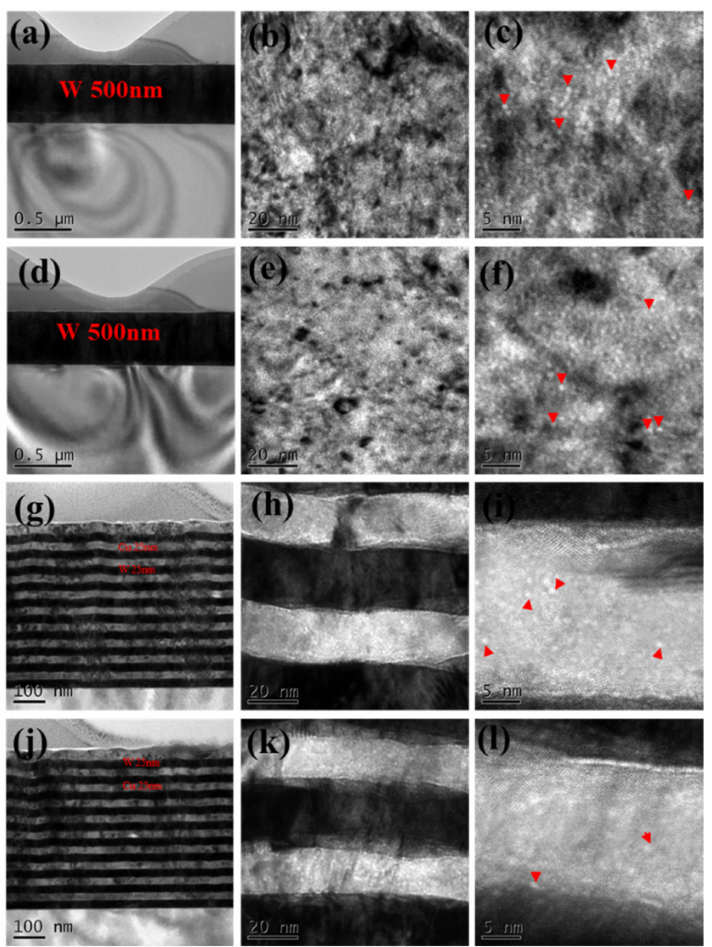
Figure 3. The microstructure of the W monolayer and the W/Cu-25 nanocomposite after He + irradiation: ( a ) The cross–sectional TEM–bright field (TEM–BF) image, ( b , c ) the helium bubbles, under focus ~300 nm, of He + irradiated W monolayer at RT; ( d ) the cross–sectional TEM–bright field (TEM–BF) image, ( e , f ) the helium bubbles, under focus ~300 nm, of He + irradiated W monolayer at 400 ◦ C; ( g ) the cross-sectional TEM-bright field (TEM-BF) image, ( h , i ) the helium bubbles, under focus ~300 nm, of He + irradiated W/Cu-25 at RT; ( j ) the cross-sectional TEM-bright field (TEM-BF) image, ( k , l ) the helium bubbles, under focus ~300 nm, of He + irradiated W/Cu-25 at 400 ◦